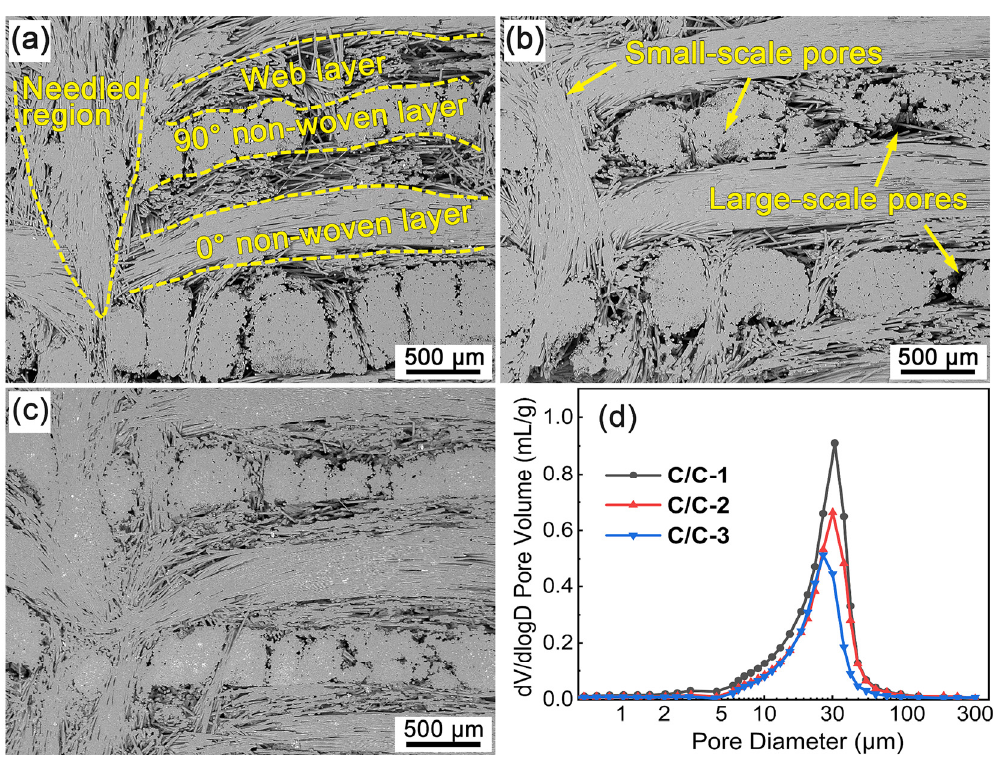
Figure 2. Cross-section SEM micrographs and pore size distributions of the porous C/C composites: ( a ) C/C-1; ( b ) C/C-2; ( c ) C/C-3; ( d ) Pore size distribution.